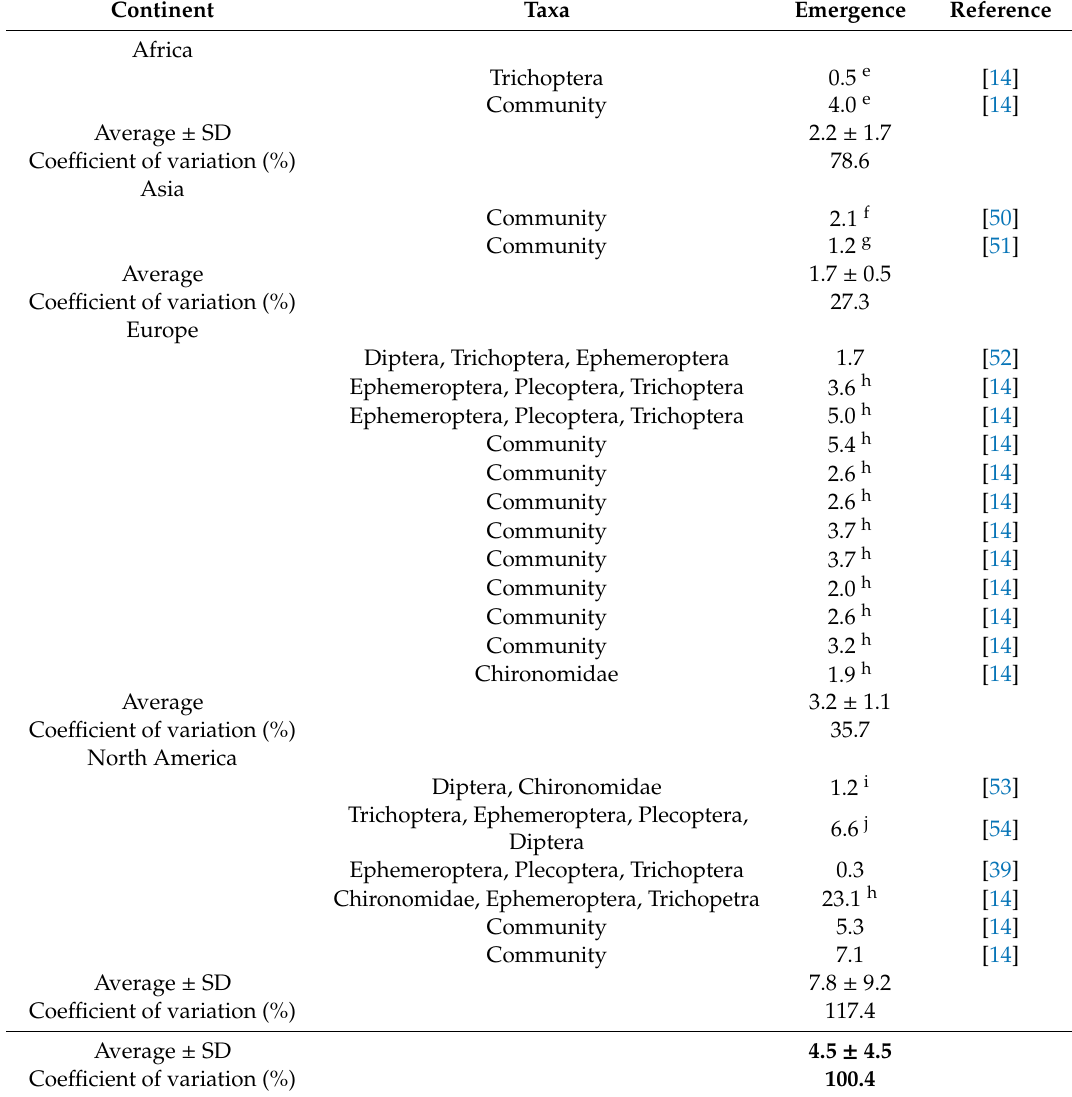
Table 2. Insect emergence from rivers (g DM m − 2 year − 1 ) for available continents. ‘Community’ denotes instances where whole taxa values are reported. Values in ‘bold’ denote the grand means and standard deviation for all available data. Average and coe ffi cient of variation in bold represents the grand average that was used to calculate emergence for Australia and South America.